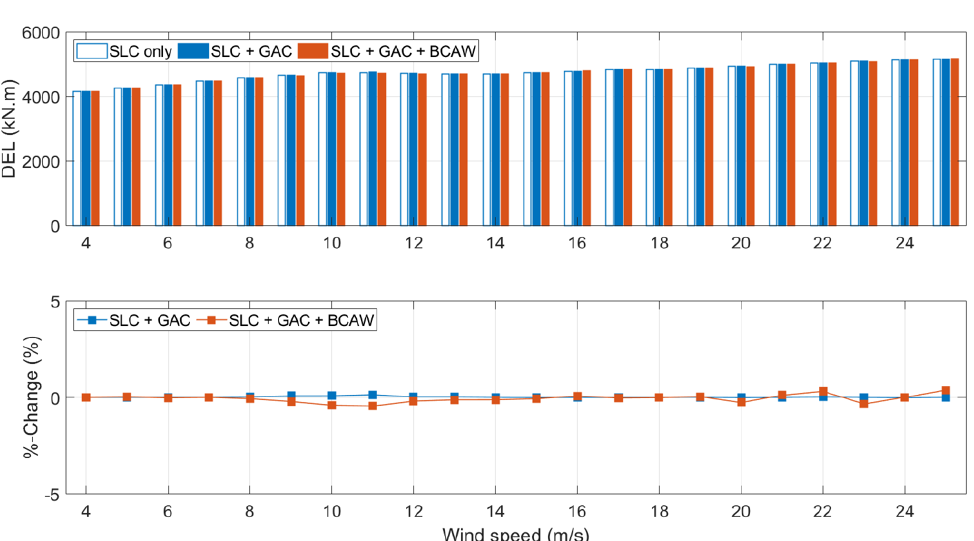
Figure A5. Variation of the DELs of the blade root edgewise bending moments from cut-in to cut-out wind speed under DLC 1.2 with different control architectures. Top—Dimensional DELs; Bottom—Percentage changes with respect to the ‘SLC Only’